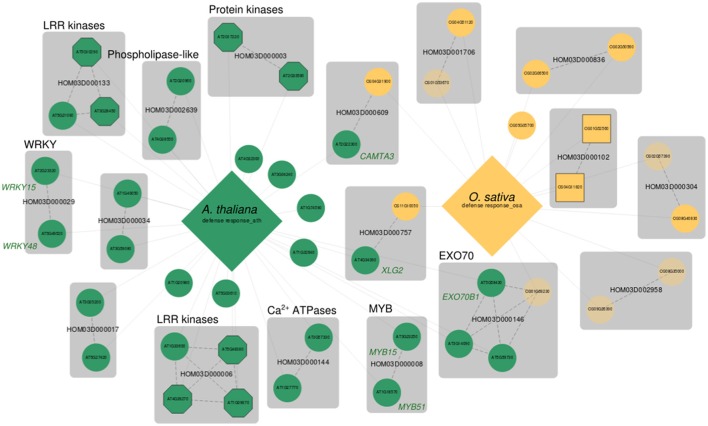
Comparative MorphDB network of GO:0006952 (defense response) for A. thaliana and O. sativa. A. thaliana genes are indicated in green, O. sativa genes indicated in yellow. Only genes among the top 100 candidates for this process with a homologous relation to another candidate in MorphDB for the same GO category are included for clarity. Large diamonds represent the bait gene set and candidate genes are connected to their respective bait set. Bait genes themselves are omitted for clarity as well. Genes with no functional description are depicted transparently. Transporters are shown as squares and kinases and receptors as octagons. All other candidate genes are shown as circles. Gene families are shown as gray compound nodes and orthology relationships as dashed edges.